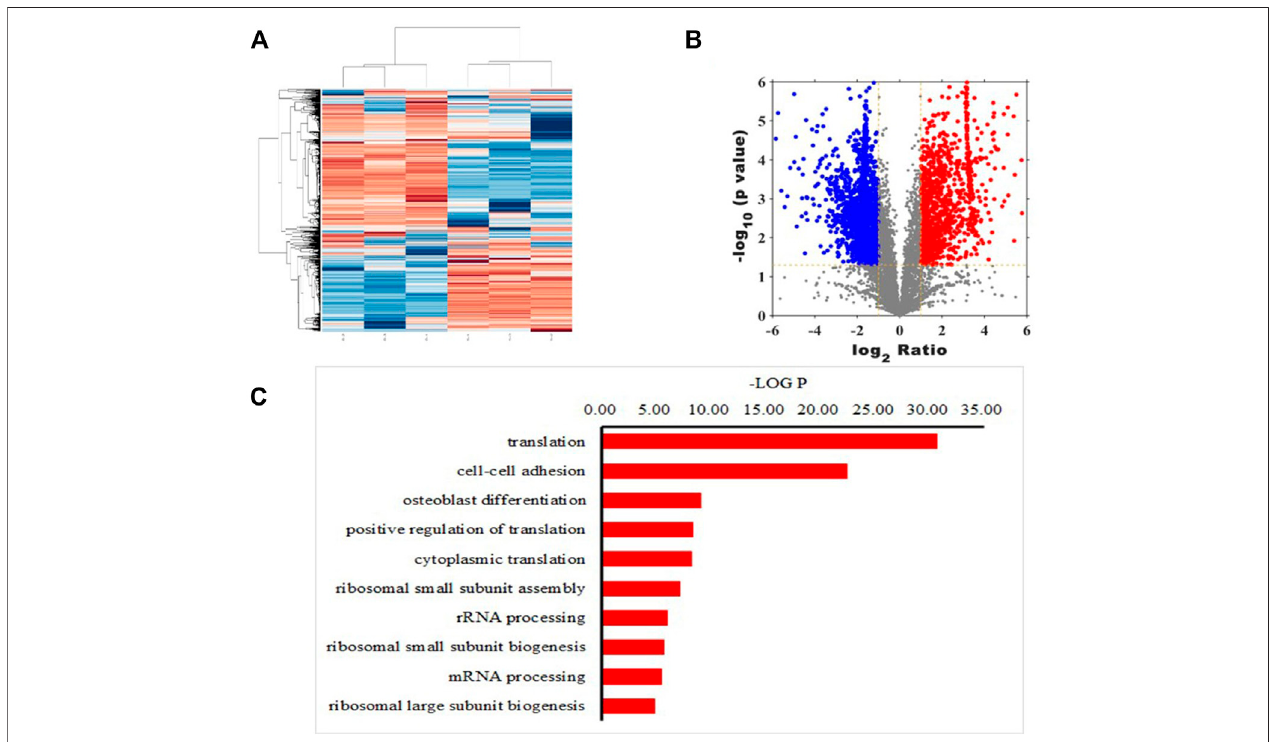
FIGURE1| Quantitative peptide analysis.Heat map (A) and volcanoplot (B) showing differencesinabundance ofpeptides screened between lipopolysaccharide (LPS)-treated and control groups. X -axis represents the intensity ratio of peptides in the two groups of samples, Y -axis represents the p value representing inter-group repeatability, and each point in the plot represents an individual peptide. Red and green areas indicate upregulated and downregulated peptides, respectively (C) Ten biological processes with the highest protein enrichment corresponding to differential polypeptides.